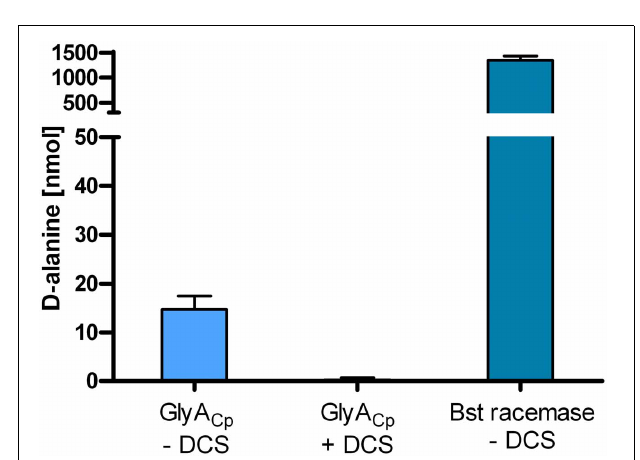
empty vector) were grown on solid (A) or in liquid (B) LB medium under limited D-Ala growth conditions at 42 ◦ C. LB medium was supplemented with 5mg/L D-Ala, 50 μ M of cofactor PLP, 25 μ g/ml thymine and 50 μ g/ml ampicillin. Expression of GlyA Cp was induced by the addition of 0.1mM IPTG.